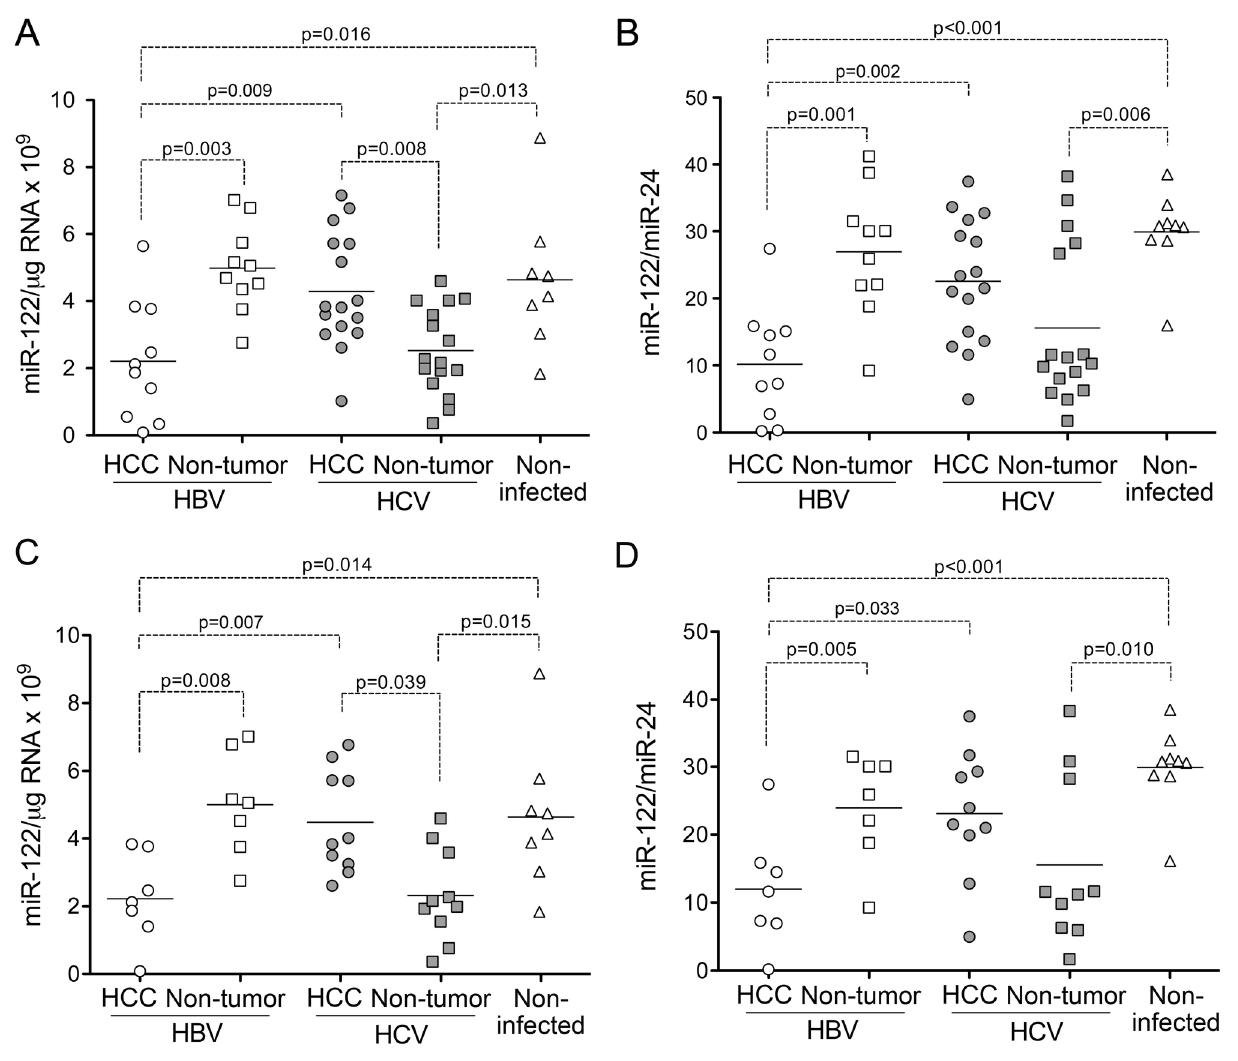
Figure 2. miR-122 expression in paired HCC and non-tumor liver tissue from patients with chronic HBV and HCV infection and control, non-infected liver tissue. ( A ) miR-122 abundance quantified by qRT-PCR in paired tumor and non-tumor tissues and non-infected (‘normal’) liver from patients undergoing resection of metastatic tumors, normalized to total RNA. ( B ) Relative miR-122 abundance normalized to miR-24 abundance in the same tissues. ( C ) miR-122 abundance in HCC classified histologically as “moderately differentiated”, paired non-tumor tissue from the same patients, and non-infected (‘normal’) liver. ( D ) miR-122 abundance in the subset of tissues shown in panel C, normalized to miR-24 abundance. The statistical significance of differences between paired observations was estimated using the paired t test, while differences between non-paired observations were analyzed by the Mann-Whitney